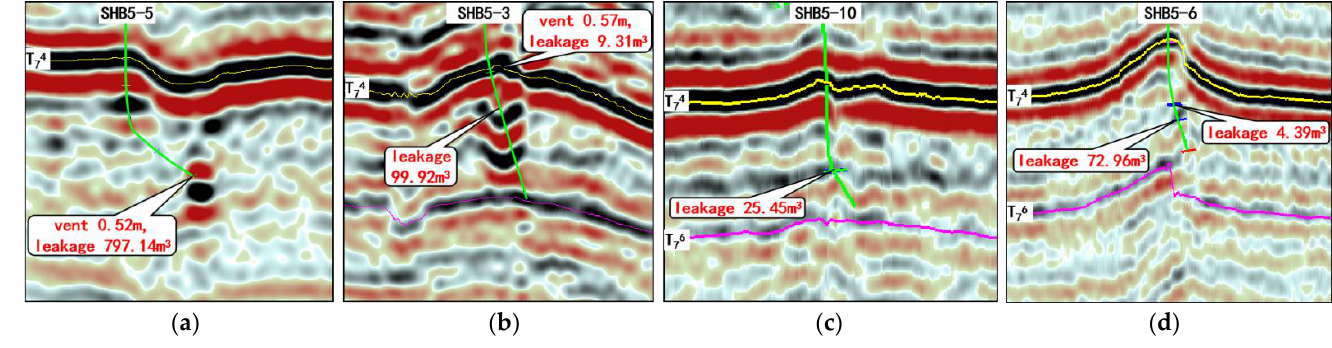
Figure 4. A fault profile and plane characteristics of Yijianfang Formation marker wave group. ( a ) seismic profile. The pink box indicates the location and data of drilling venting and leakage; ( b ) weak coherence stratum slice along T 74 seismic horizon. The color represents the coherence value. The darker the color is, the weaker it is. It can predict the plane position of fault; ( c ) weak amplitude stratum slice along T 74 seismic horizon. The color represents the amplitude attribute value. The red- der, the weaker, and the plane position of the fault is predicted.